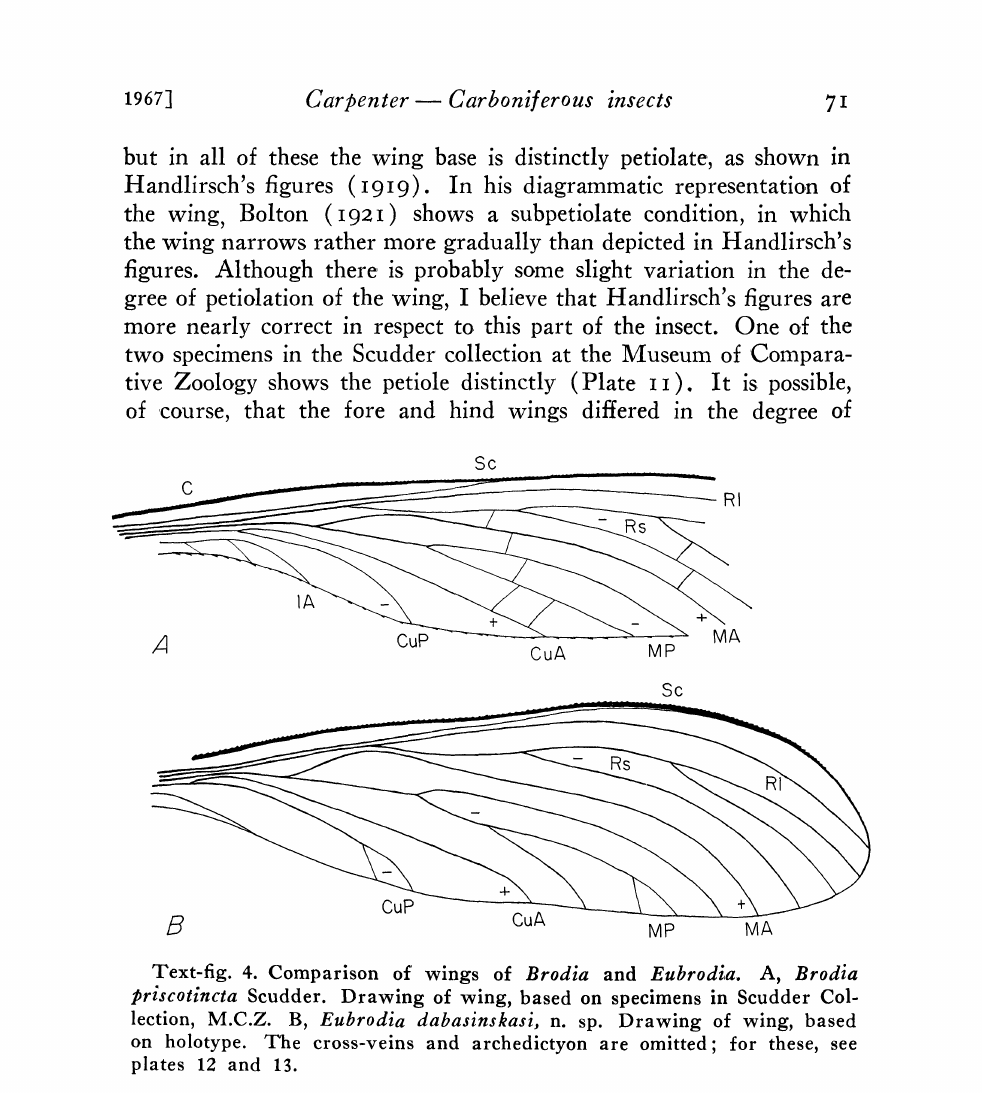
Text-fig. 4. Comparison of’ wings of Brodia and Eubrodia. A, Brodia priscotincta Seudder. Drawing of wing, based on specimens in Seudder Col- lection, M.C.Z. B, Eubrodia dabasinskasi, n. sp. Drawing of wing, based on holotype. The cross-veins and arehedietyon are omitted; for these, see plates 12 and 13. EXPLANATION OF PLATE 11 Brodia priscotincta Scudder. Upper Carboniferous of England. Fig.1. Photograph of specimen no. 5842 in M.C.Z. (Scudder Collection), showing the petiole and the transverse, dark bands on the wing. Actual length of wing as preserved, 55 mm. Fig. 2. Photograph of specimen no. 5843 in M.C.Z. (Scudder Collection), showing the dense pattern of fine cross veins; photographed under very oblique light. Actual length of wing, as preserved, 36